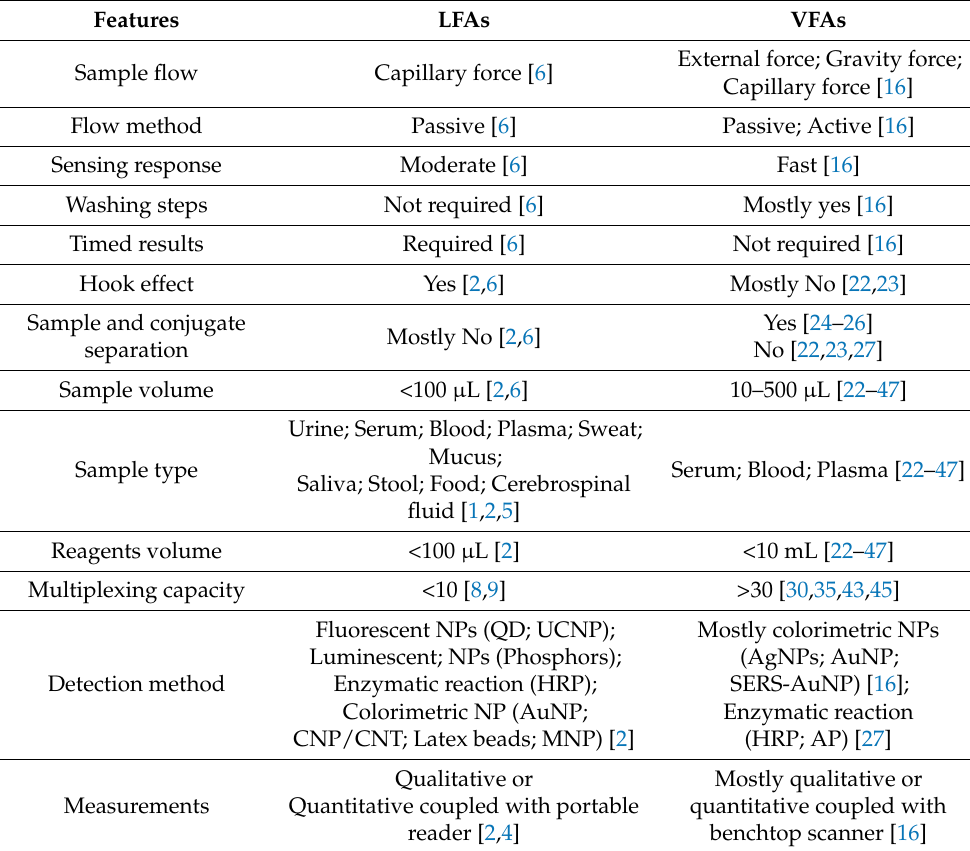
Table 1. Comparison between LFAs and VFAs for POCT